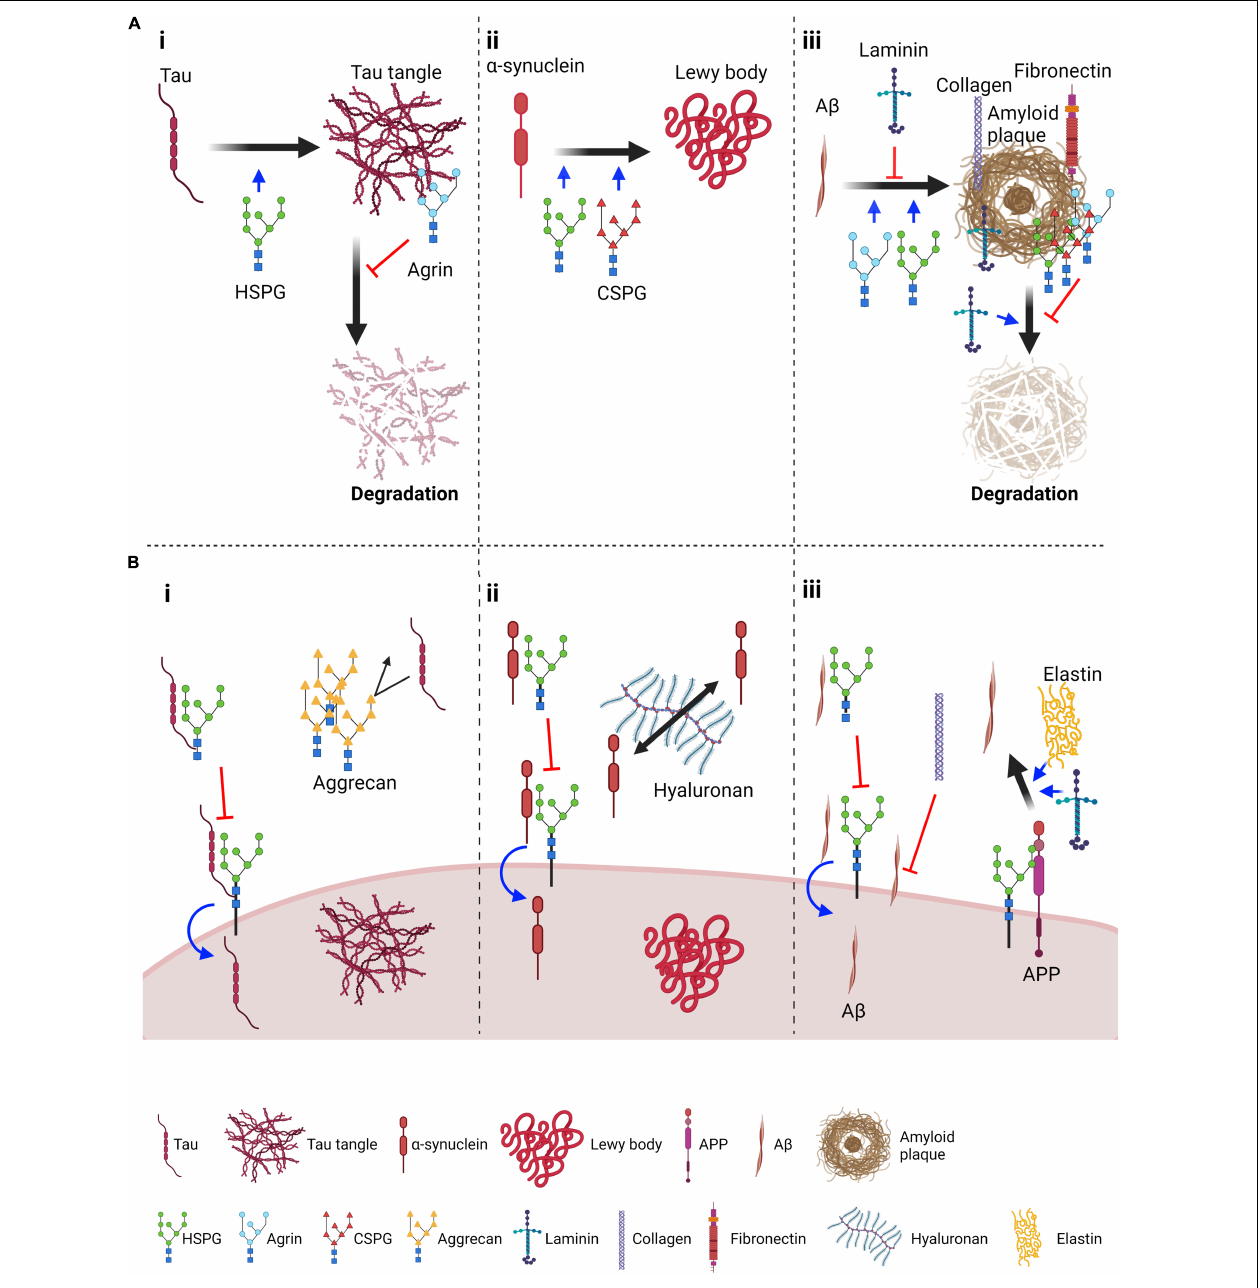
FIGURE 1 | Roles of proteoglycans and ECM components in the aggregation and spreading of tau, α -synuclein and amyloid β . (A) Sugg e sted roles of proteoglycans and core ECM components in aggregation and degradation of pathological protein aggregates: (i) Tau panel: HSPGs promote tau aggregation; Agrin, an extracellular HSPG, localizes on neurofibrillary tangles and prevents their degradation; (ii) α -synuclein panel: HSPGs and CSPGs promote aggregation of α -synuclein; (iii) A β panel: HSPGs and agrin can promote A β aggregation whereas laminin has been suggested to impair this process. Several proteoglycans, including HSPGs, agrin and CSPGs, and ECM components such as laminin, collagen and fibronectin associate with amyloid plaques. Of these, laminin enhances plaque degradation whereas proteoglycans inhibit this process. (B) Suggested role of proteoglycans and ECM components in endocytosis and spreading: (i) Tau panel: HSPGs on the plasma membrane favor tau seed endocytosis. In contrast, if tau is bound to extracellular HSPGs, its interaction with surface HSPGs might be inhibited, thus reducing tau endocytosis. Aggrecan perineuronal nets have been shown to reduce propagation of tau pathology, possibly by acting as a barrier; (ii) α -synuclein endocytosis is also promoted by HSPGs and similarly extracellular HSPGs can inhibit endocytosis. In the extracellular space, hyaluronan was found to promote spreading of α -synuclein pathology; (iii) A β panel: as for tau and α -synuclein, transmembrane HSPGs can promote internalization of A β , and this might be inhibited by extracellular interactions. Collagen has been found to reduce the interaction of A β peptides with the cell surface. HSPGs have also been found to promote A β production from APP, a process that is also promoted by ECM components such as elastin and laminin. Figure was prepared with Biorender (Biorender.com).